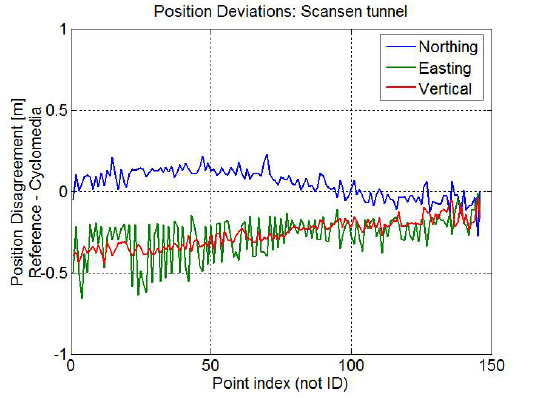
Figure 9: Differences in position between Cyclomedia based and survey based in-tunnel positioning inside the Skansen